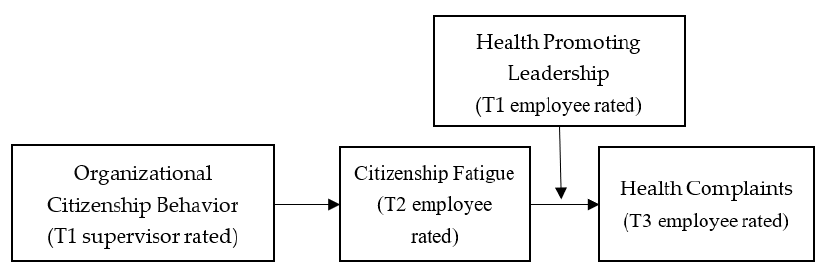
Figure 1. Hypothesized theoretical model.